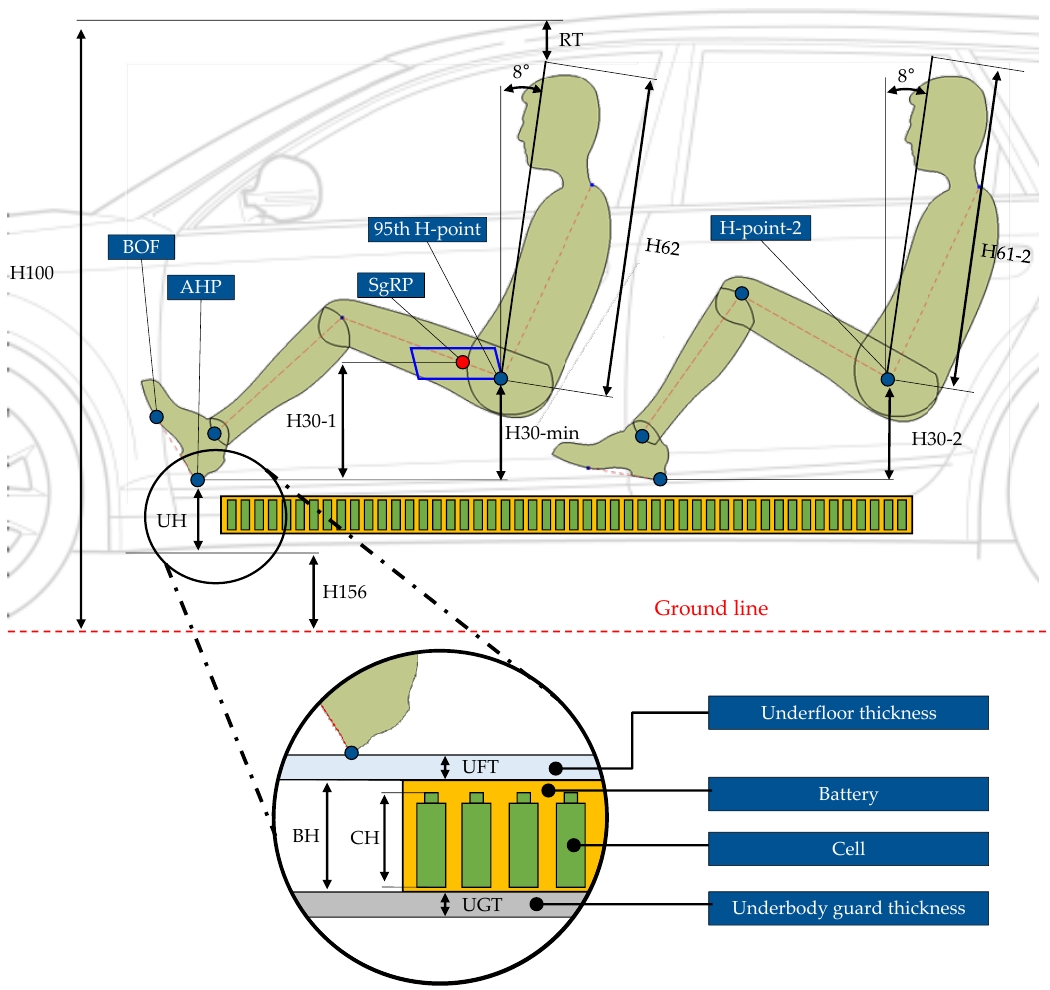
Figure 6. Overview of the dimensional chains in the Z-direction [26.]